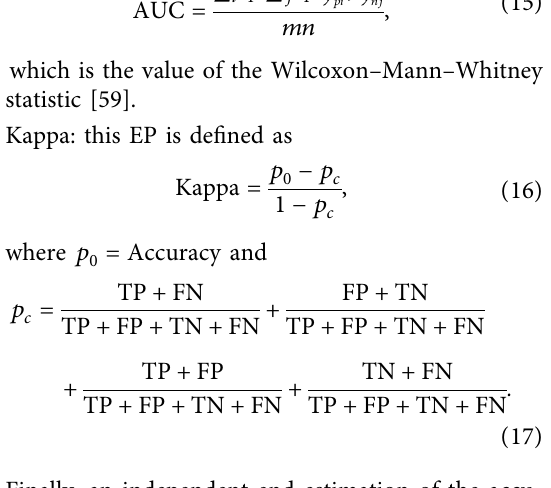
Table 1: Confusion matrix for a binary classification